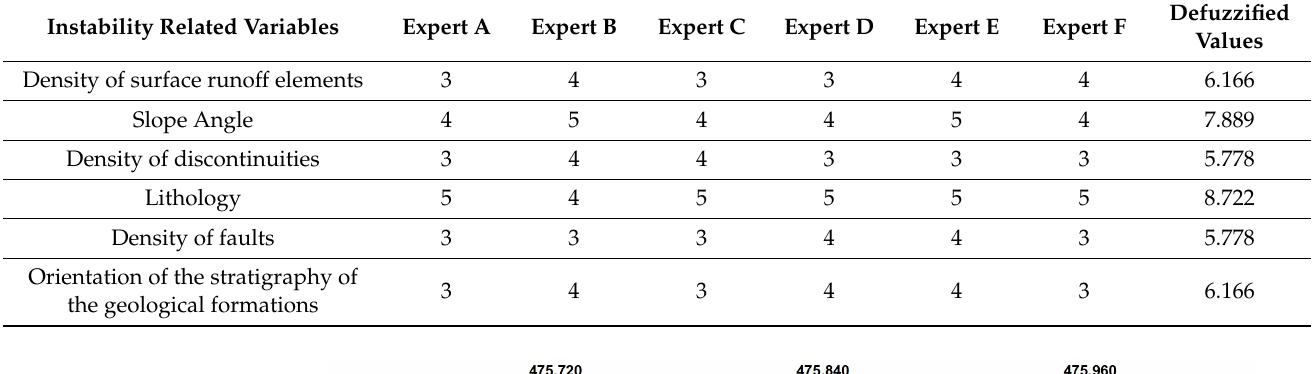
Table 2. Instability-related variables and importance weight (crisp values).